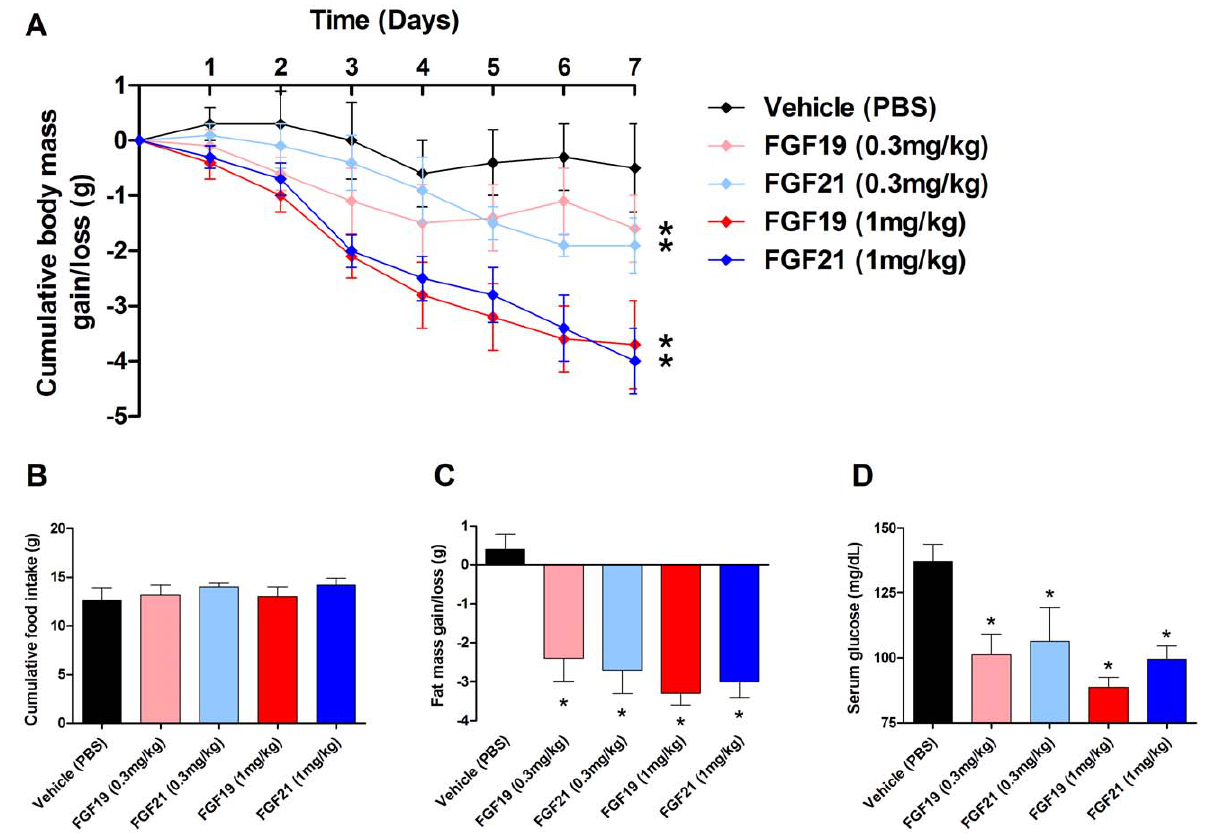
Figure 5. Treatment of DIO mice with either FGF19 or FGF21 improves metabolic dysfunction. Administration of recombinant FGF19 or FGF21 led to a reduction in body mass in a dose dependent fashion (A). Both FGF19 and FGF21 therapy led to a trend towards increased food intake, however, these differences were not significant (B). Treatment with FGF19 or FGF21 significantly reduced adiposity at both doses tested again in a dose dependant manner (C), All FGF treatments caused a significant reduction in serum glucose in DIO animals, furthermore, the reduction in glucose observed with the two proteins was strikingly similar (D).